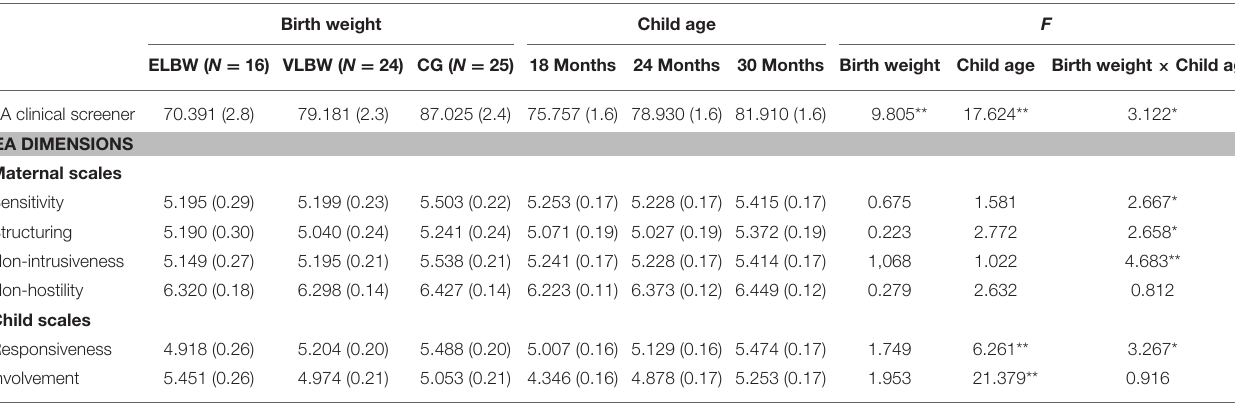
TABLE 3 | Mother-child interactive behaviors (EAS): differences among groups. Birth weight Child